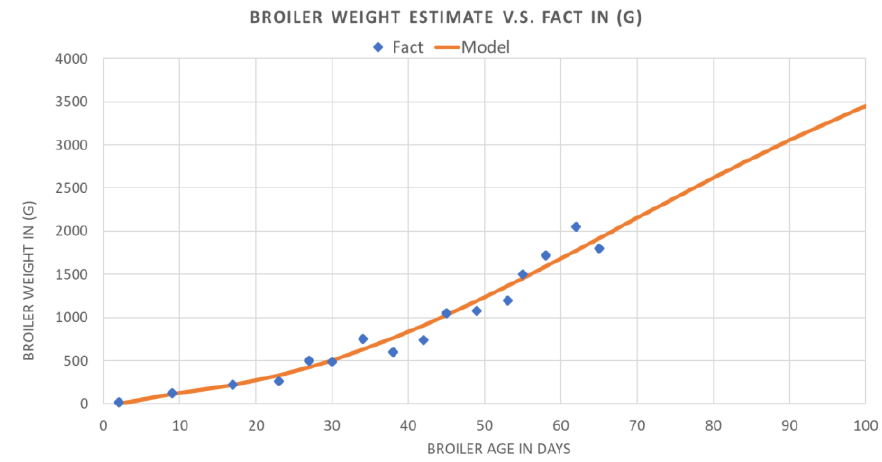
Figure 6 . Broiler weight model vs. factual measurements in barn